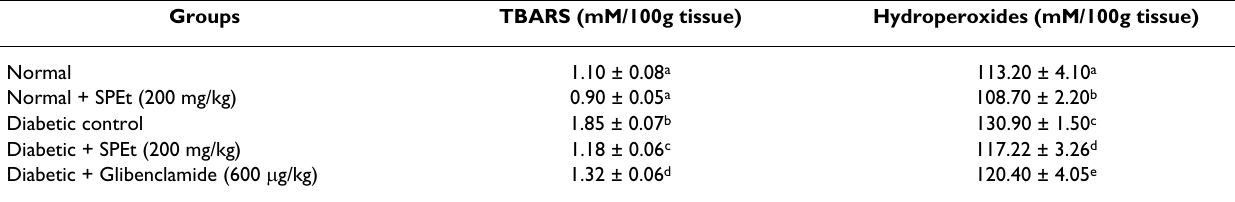
Table 2: Change in the levels of brain TBARS and hydroperoxides in normal and experimental rats